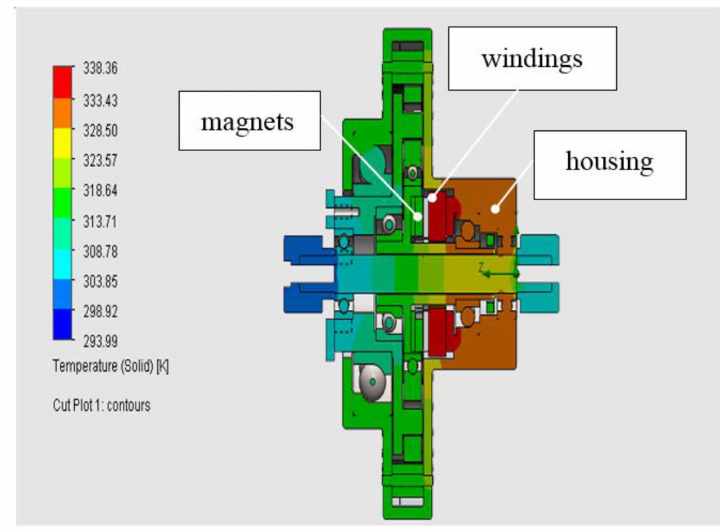
Figure 9. Steady-state temperature distribution (at 4100 s).